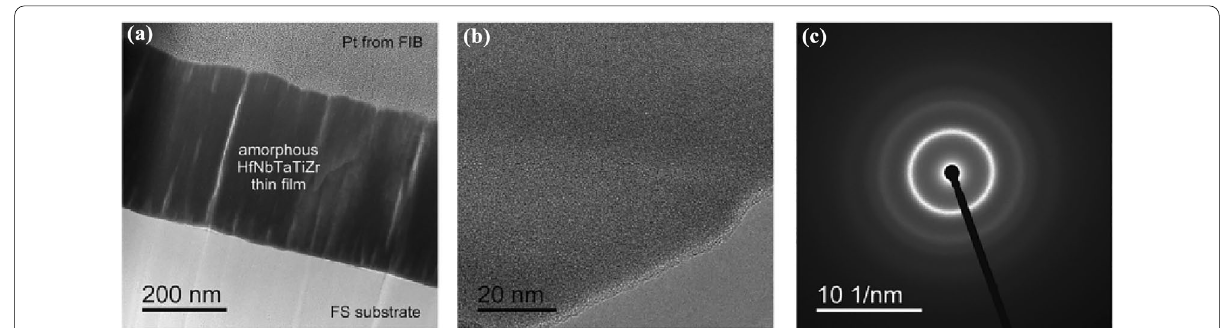
Figure 14 TEM measurements of amorphous 380 nm thick HfNbTaTiZr film: ( a ) cross-section of FIB cut lamella, ( b ) TEM image of HEA film layer, ( c ) electron diffraction pattern taken from HEA film region